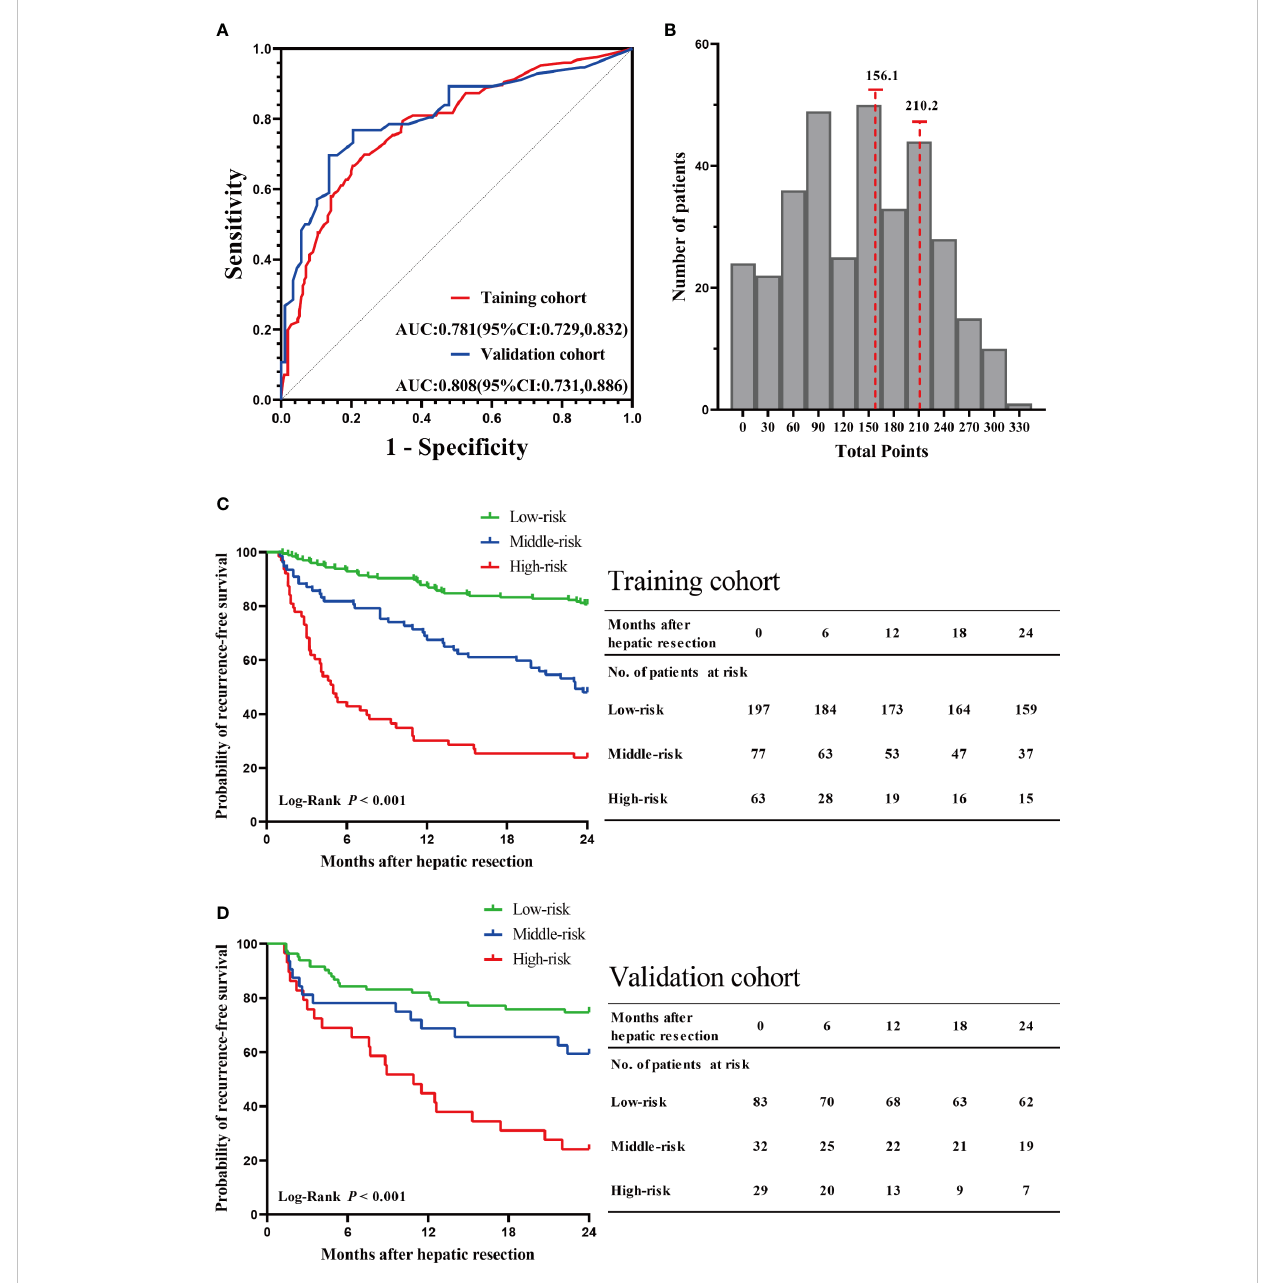
FIGURE 6 Validation of the nomogram model. (A) The ROC curve and AUC with 95% CI in the training cohort and validation cohort. (B) The two optimal cutoff points of the risk scores were determined by the X-tile software. Kaplan – Meier survival analysis of the high-risk, middle-risk, and low-risk HCC patients in the training cohort (C) and validation cohort (D)